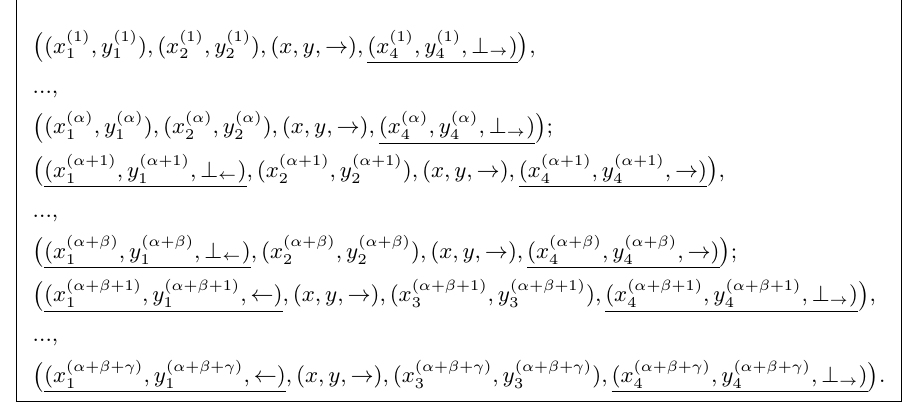
Figure 2: 2-chains and 3-chains addressed by a call to ProcessRecord ( x, y, → ), where α , β and γ are sequence